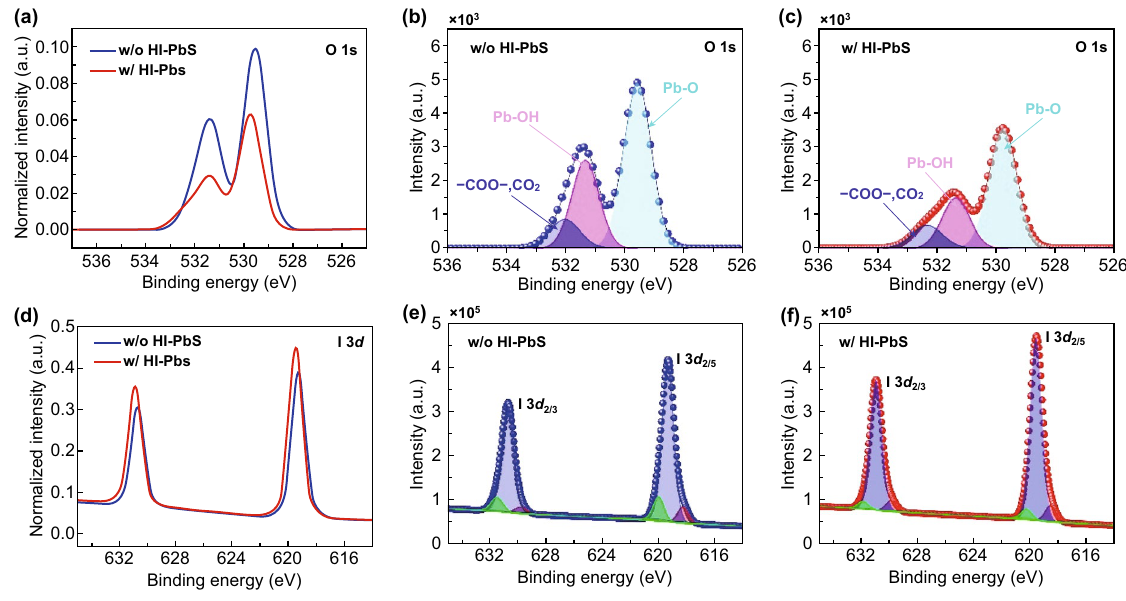
Fig. 3 XPS spectra of w/and w/o HI‑PbS‑QDs. a Signal from O 1 s of two types QDs‑ink samples. b Signal of O 1 s from the w/o HI films. c Signal of O 1 s from w/HI films. d Signal from I 3 d of two types QDs‑ink samples. e Signal of I 3 d from the w/o HI films. f Signal of I 3 d from w/HI films. The total peak areas of O 1 s and I 3 d spectra are normalized to the Pb peak area of the two type samples in a and d, respectively. To compare the relative values, the real intensity of respective peaks from b , c , e, and f are subtracted with background signal Table 1 Fitting parameters and quantitative analysis of O 1 s spectra of w/o and w/HI PbS‑QDs films in Fig. 3